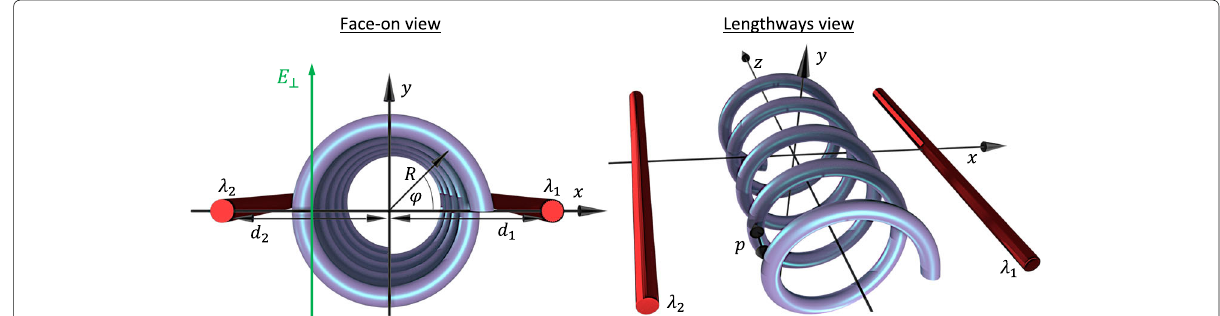
Fig. 1 Diagram of the system’s geometry and parameters from both face-on and lengthways perspectives. R is the helix radius, and d 1 and d 2 are the distances of the charged wires from the helix axis with charge densities λ 1 and λ 2 , respectively. The spatial coordinate ϕ describes the angular position on the helix from face-on and is related to the z -coordinate via ϕ = 2 π z / p with p the helix’s pitch. A transverse electric field E ⊥ is applied parallel to the y